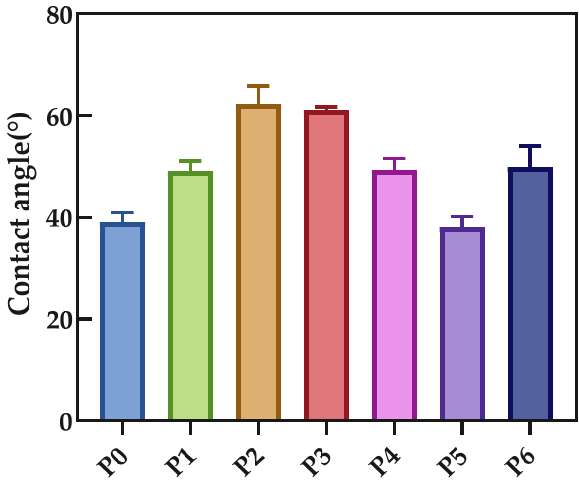
Figure 9. Contact angle of various PA66 membranes.